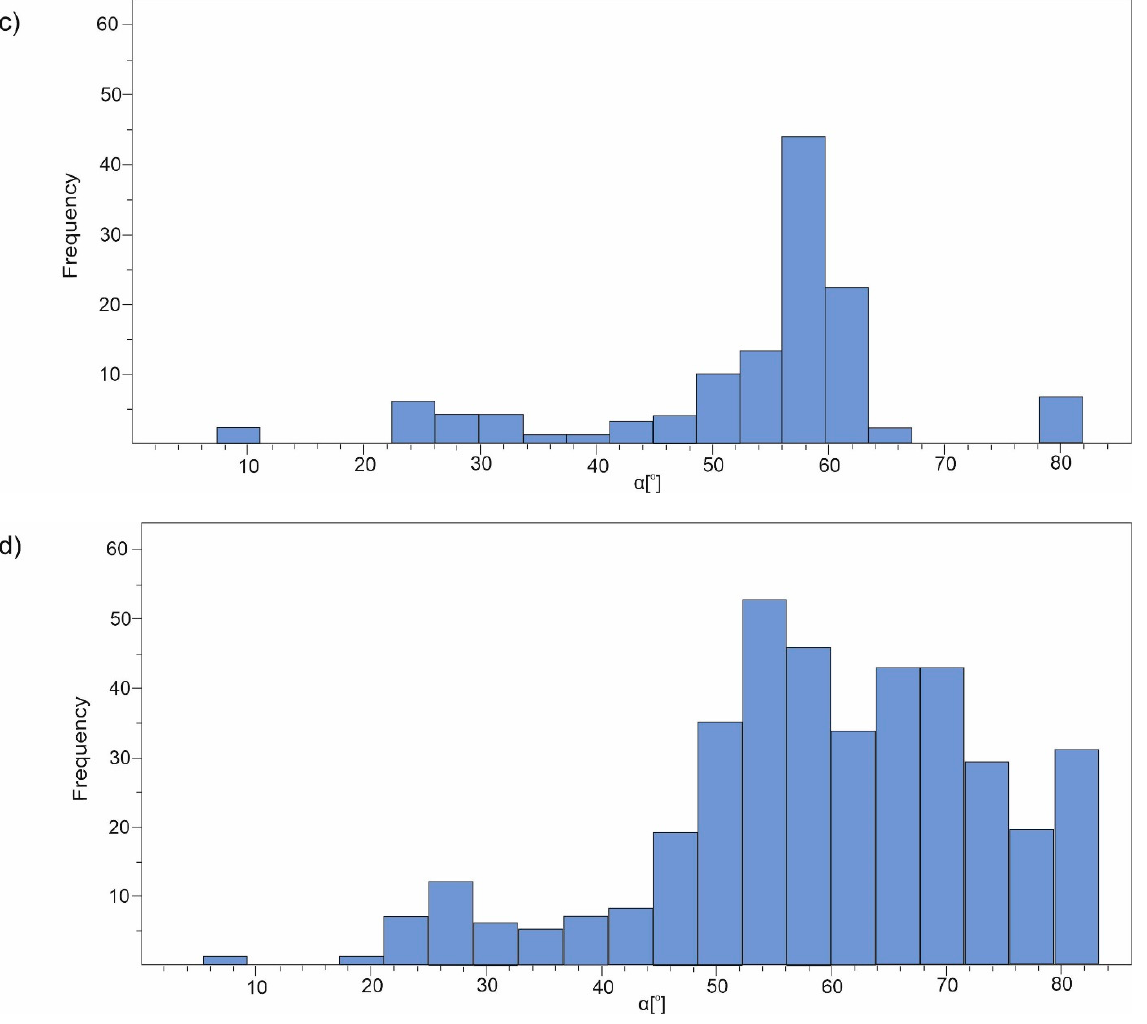
Figure 1. Histogram for the α angle of 5 H ‐ dibenzo[b,f]azepine ( a ), 5 H ‐ dibenzo[a,d][7]annulene ( b ), 10,11 ‐ dihydro ‐ 5 H ‐ dibenzo[b,f]azepine ( c ) and 10,11 ‐ dihydro ‐ 5 H ‐ dibenzo[a,d][7]annulene ( d